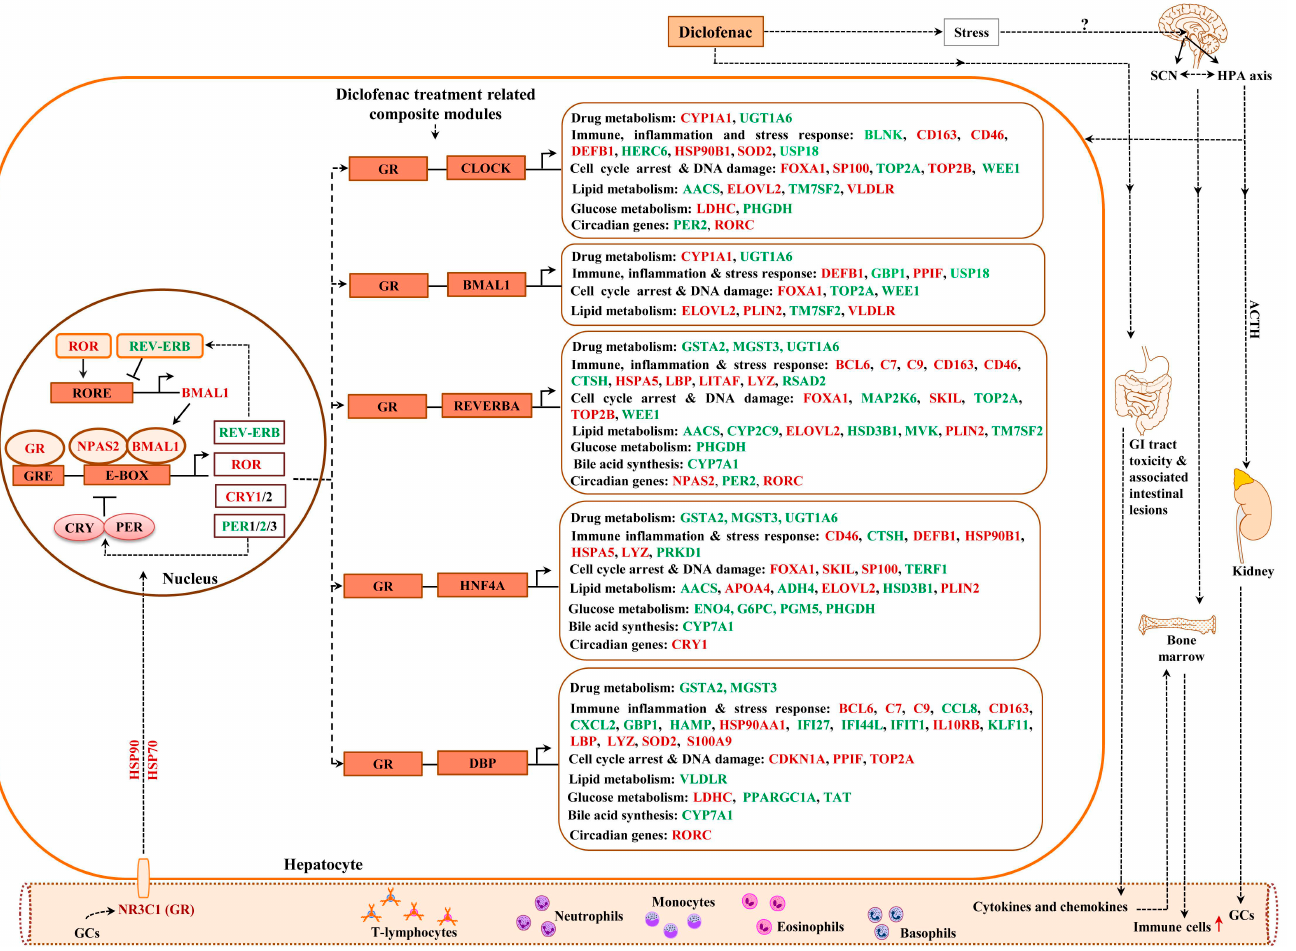
Figure 13. Liver clock and glucocorticoid receptor co-regulated genes in response to diclofenac treat- ment. Shown are composite modules of circadian transcriptional regulators and the glucocorticoid receptor at the gene-specific promoters of hepatic DEGs coding for immune response, inflammation, metabolism, cell cycle arrest and DNA damage. Genes marked as red are significantly up-regulated; those given in green are repressed in expression.